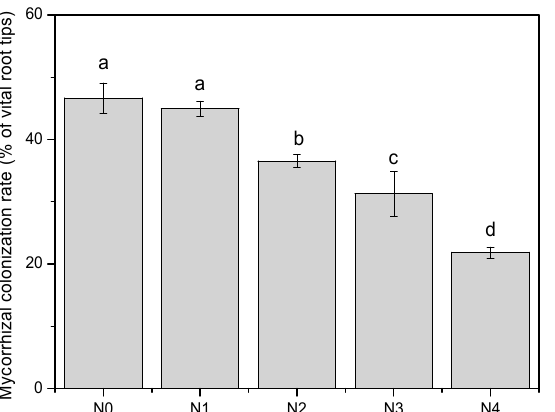
Figure 1. Colonization rate of the ectomycorrhizal fungi of the poplar plantation under five N addition treatments: N 0 : 0 kg N ha − 1 yr − 1 , N 1 : 50 kg N ha − 1 yr − 1 , N 2 : 100 kg N ha − 1 yr − 1 , N 3 : 150 kg N ha − 1 yr − 1 , and N 4 : 300 kg N ha − 1 yr − 1 . Values indicate means ± SE ( n = 4). Different letters indicate significant differences between means (Tukey’s HSD pairwise comparisons). Table 2. Alpha diversity of the ectomycorrhizal species of the poplar plantation under five N addition treatments. Alpha diversity indices were based on richness, diversity (Shannon and Simpson), and evenness (Pielou). N 0 : 0 kg N ha − 1 yr − 1 , means ± SE ( n = 4). Different letters indicate significant differences between means (Tukey’s HSD pairwise comparisons). Alpha Diversity N 0 N 1 N 2